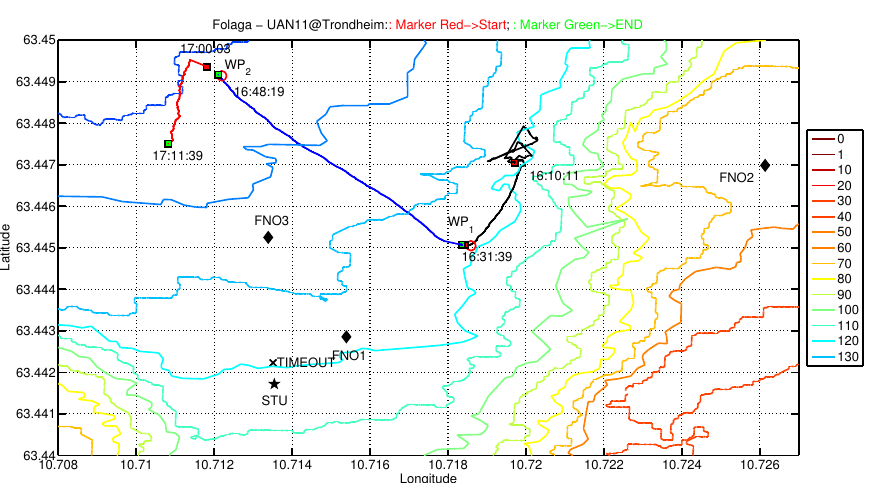
Figure 13. Folaga path during the experimental activity on May 27. In the first part of the day the vehicle was acoustically controlled by the UAN command and control center to proceed to deeper investigation in an area where an intruder was detected. However, the C2 moved the vehicle too far from the network where it lost the connectivity. According to the behavior described in Section 3 the vehicle autonomously planned a new mission to move towards the high value asset (the base station) to protect where it could re-enter the